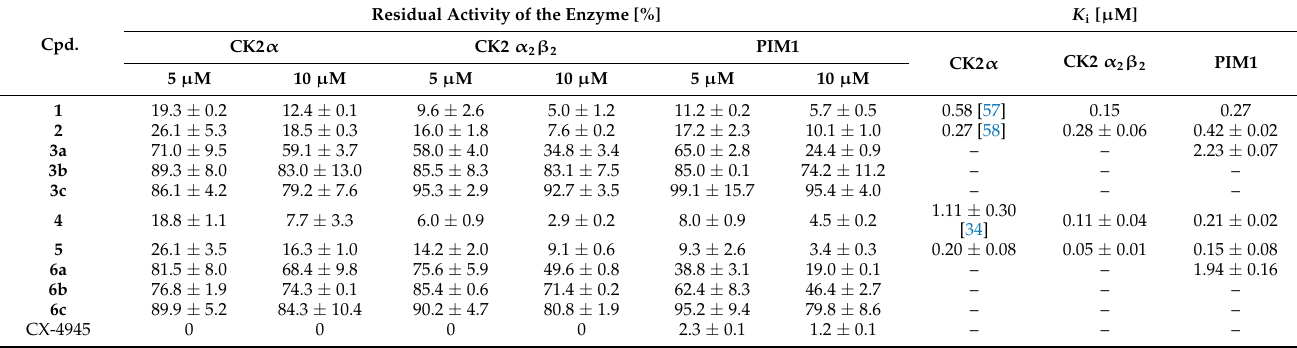
Table 1. Inhibition of CK2 and PIM1 by compounds 1 , 2 , 3a – c and 4 , 5 , 6a – c .